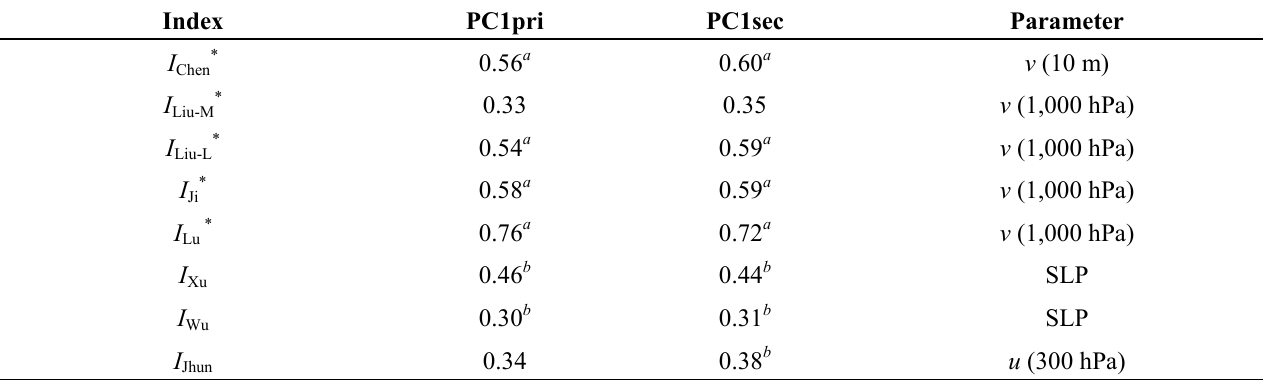
Table 2. Correlation coefficients between PC1s and EAWM indices and ancillary information. Index PC1pri PC1sec Parameter I Chen* 0.56 a 0.60 a v (10 m)